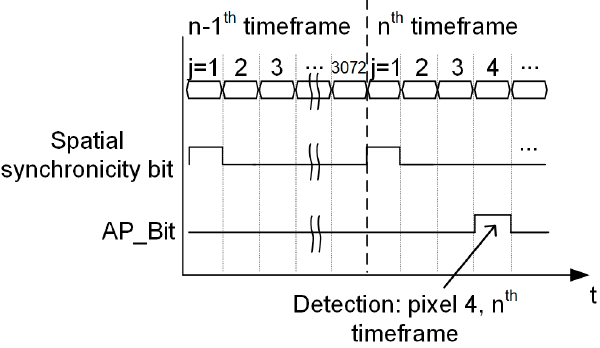
Figure 8. Output signal encoded spatial and temporal information.